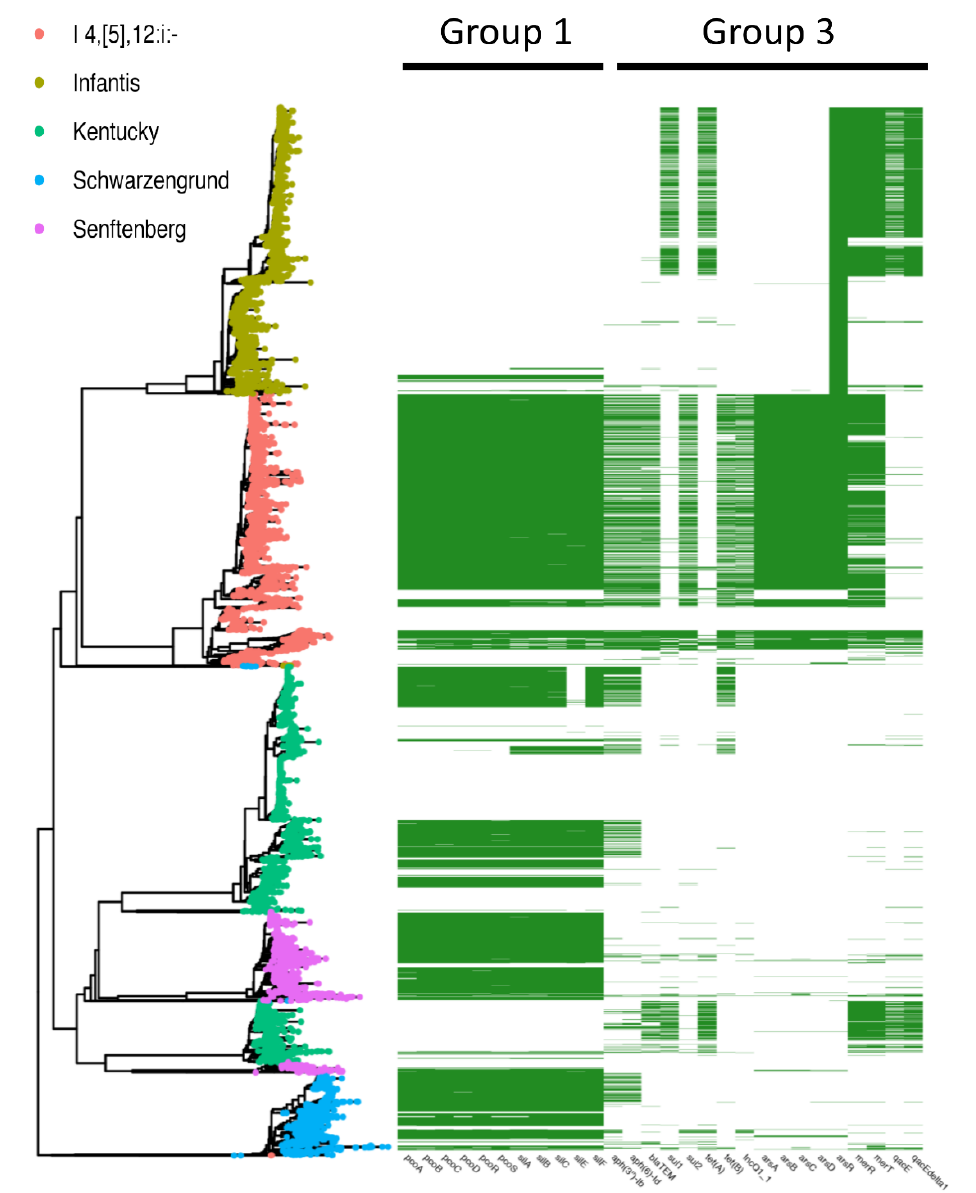
Figure 3. Distribution of Groups 1 and 3 genes among S. enterica I 4,[5],12:i:-, S. enterica Infantis, S. enterica Kentucky, S. enterica Schwarzengrund, and S. enterica Senftenberg. A presence-absence matrix of Groups 1 and 3 genes is plotted against a neighbor-joining tree constructed from a pairwise Mash distance matrix. Group 1 ( pco and sil operons) is found in S. enterica Kentucky, S. enterica Schwarzengrund, and S. enterica Senftenberg but is mostly absent from S. enterica Infantis. Group 3, which contains metal and antibiotic resistance genes, is almost exclusive to S. enterica I